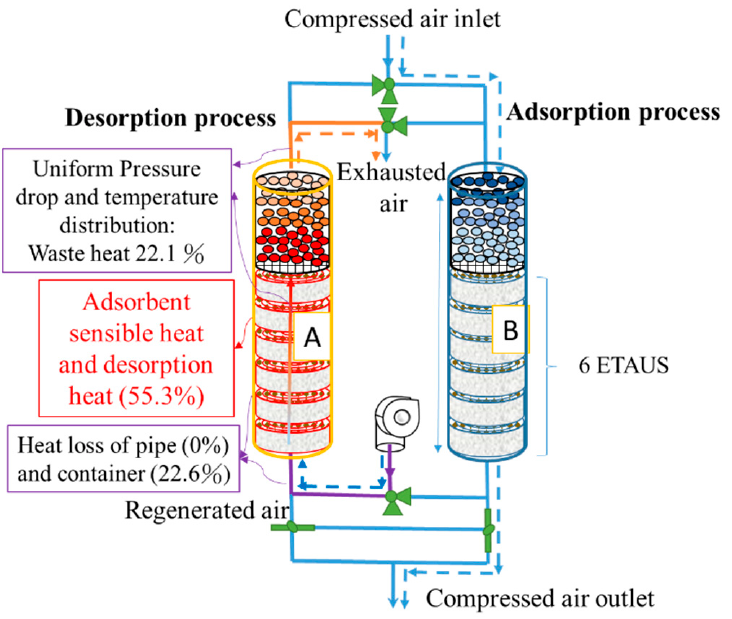
Figure 19. Energy analysis of the composite ETAU system.